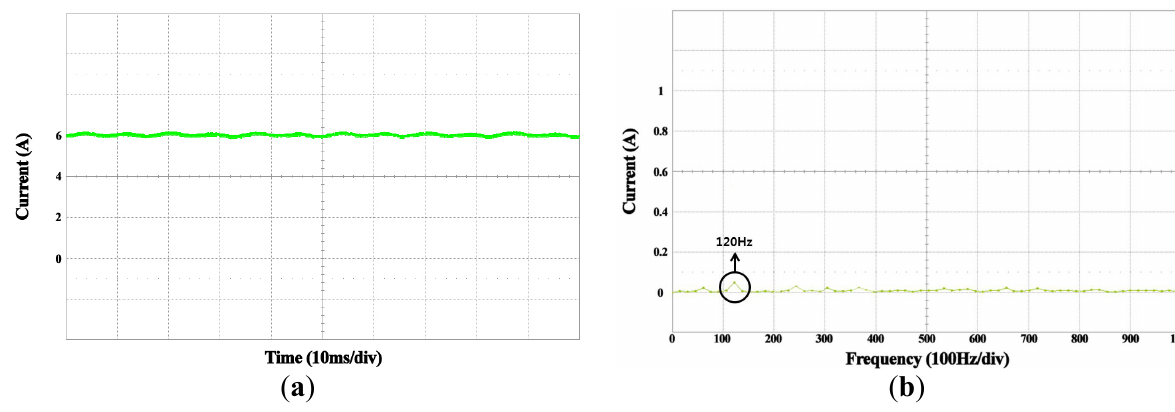
Figure 24. Magnitude of PV current with compensation. ( a ) Time domain; ( b ) frequency